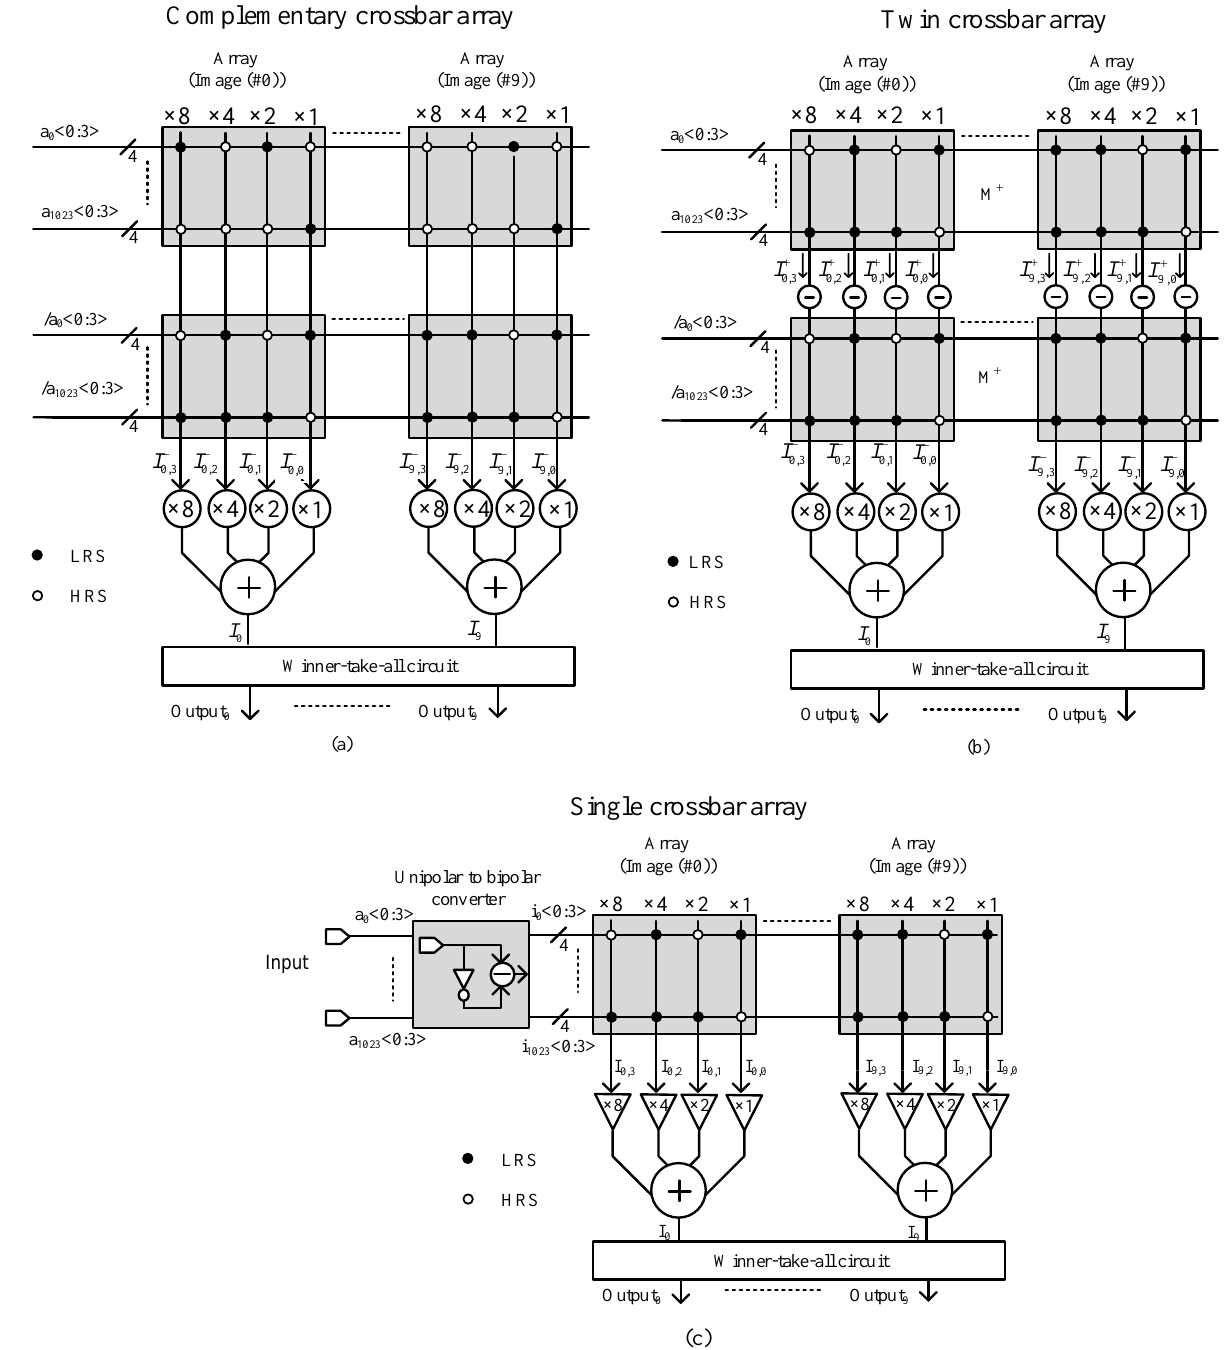
Figure 5. The block diagrams of complementary crossbar architecture ( a ), twin crossbar architecture ( b ) (Reproduced with permission from [15], published by IEEE), and single crossbar architecture ( c ) (Reproduced with permission from [16], published by IEEE) for recognizing 10 grayscale images with the size of 32 × 32 pixels.